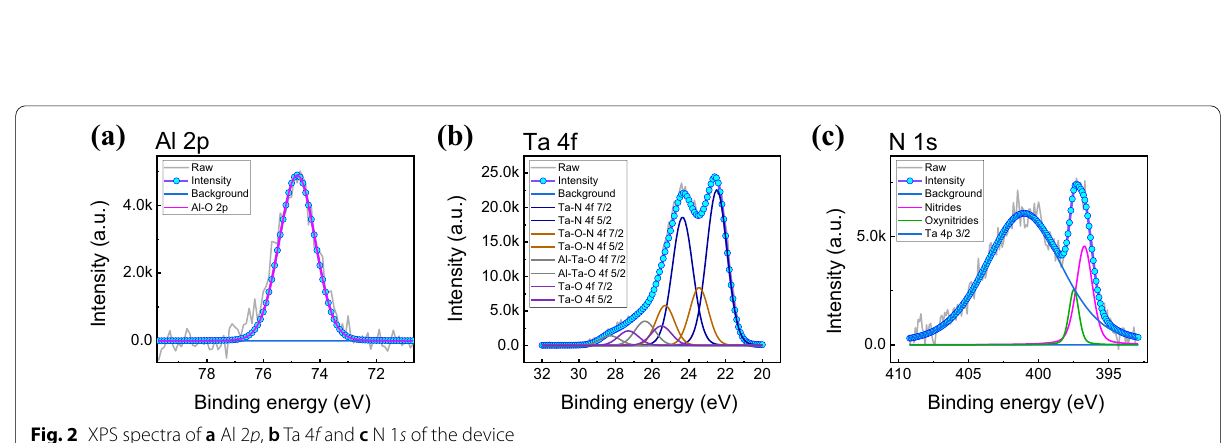
Fig. 1 a Schematics image of Pt/Al 2 O 3 /TaN device, b cross-sectional TEM image, c EDS mapping images of Pt, Al, O, Ta and N elements collected from the area indicated in the TEM image of the Pt/Al 2 O 3 /TaN device